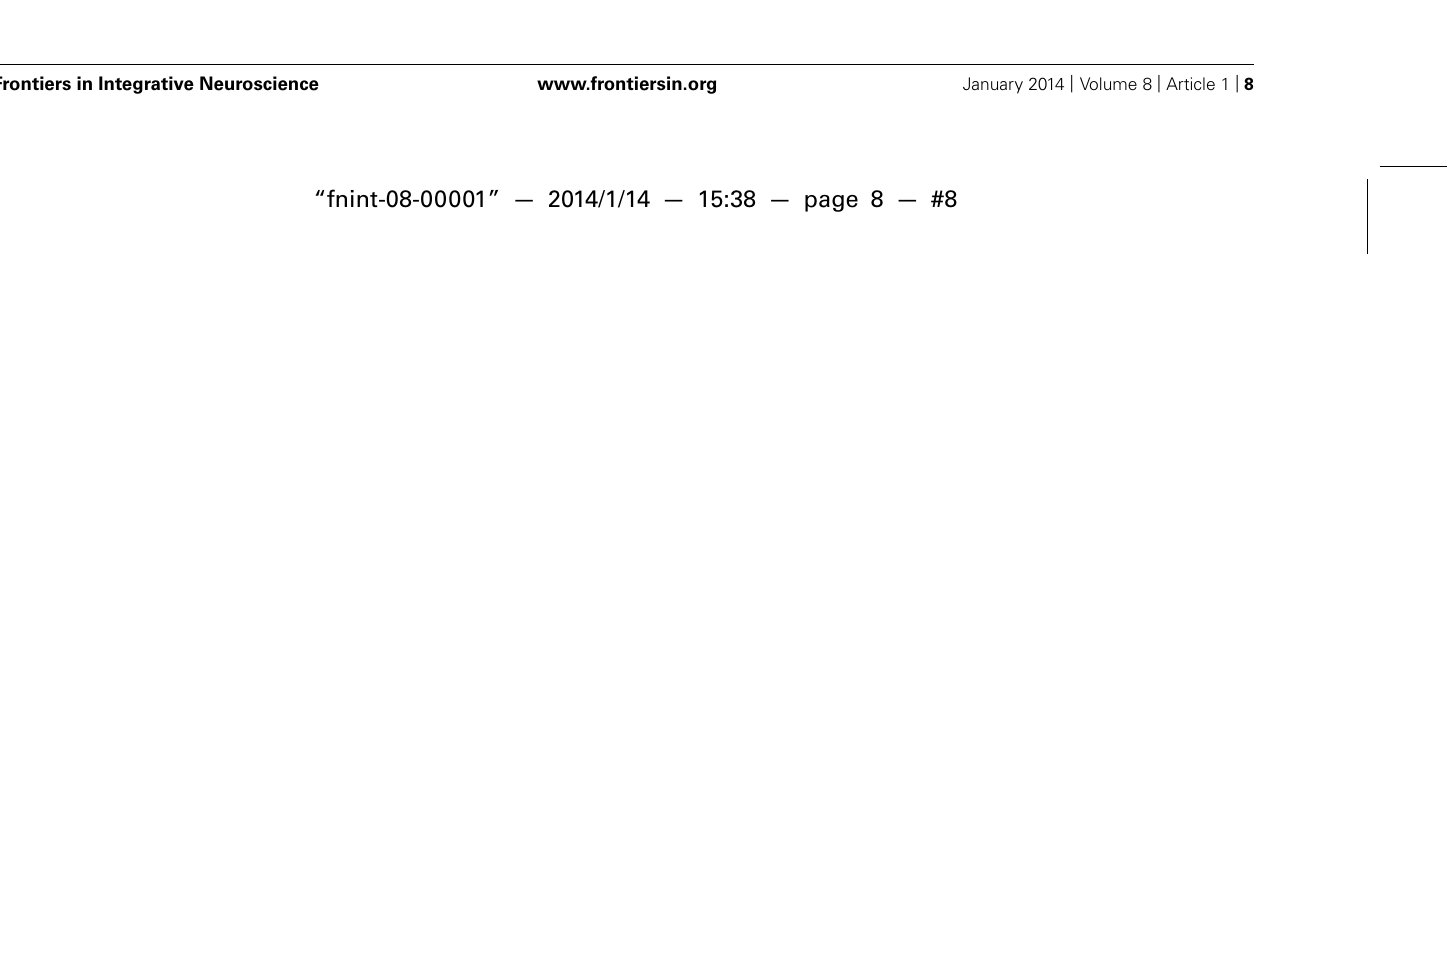
FIGURE 5 | (A) The histogram shows the average response of a population of neurons in the OT to a long sequence of stimuli (200 stimuli).The duration of each stimulus was 200 ms and the ISI was 1 s.The sequence alternated between two ITD values; every 10 repetitions the ITD of the sound was switched to the other value (protocol is illustrated in the inset at the bottom of the figure).The graph on the right shows the post-stimulus time histogram (PSTH) of one stimulus when it was first in its sub-sequence (deviant, light red curve) compared to the PSTH for the same stimulus when it was last in its sub-sequence (standard, black curve). (B) Same as A , but in this case, the two stimuli were narrowband stimuli (width of 1 kHz) differing in their central frequency. (C) Same as A and B , but in this case, the two stimuli differed in intensity. One stimulus (dark blue bars) was softer compared to the other (light red bars).The average response to deviant stimulus was greater in all